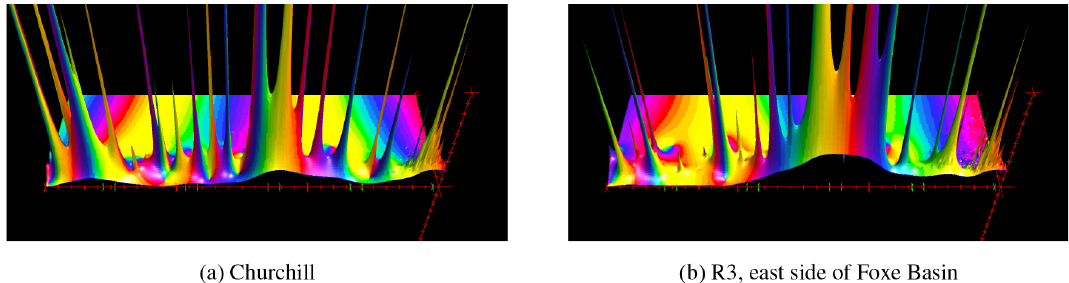
Figure 6. The response function amplitude plotted as a function of complex angular velocity (a) at Churchill and (b) location R3 on the eastern side of Foxe Basin. Colours and axes as in Fig. 5.